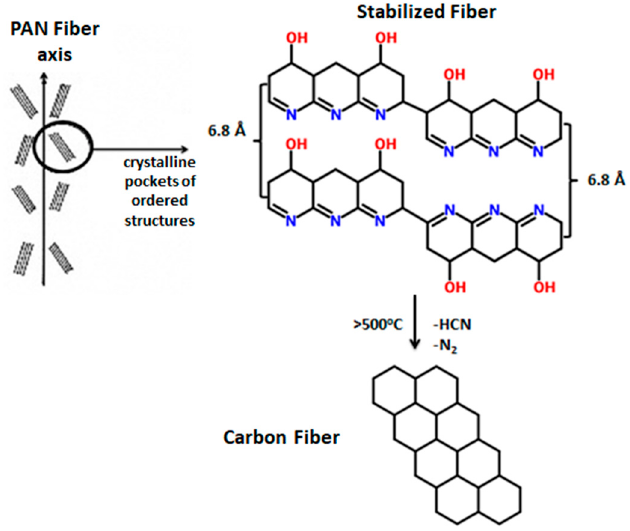
Figure 3. Carbonization mechanism of PAN fibers.